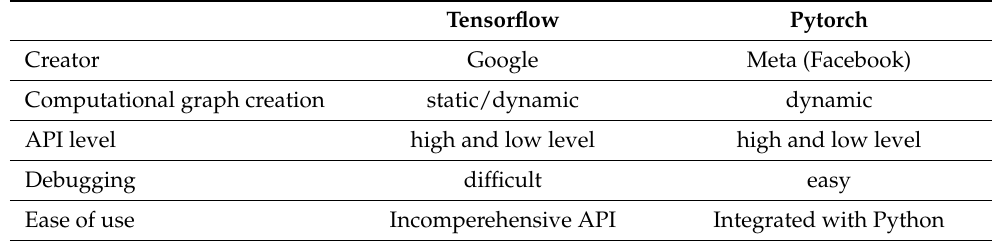
Table 1. A feature comparison between Tensorflow and